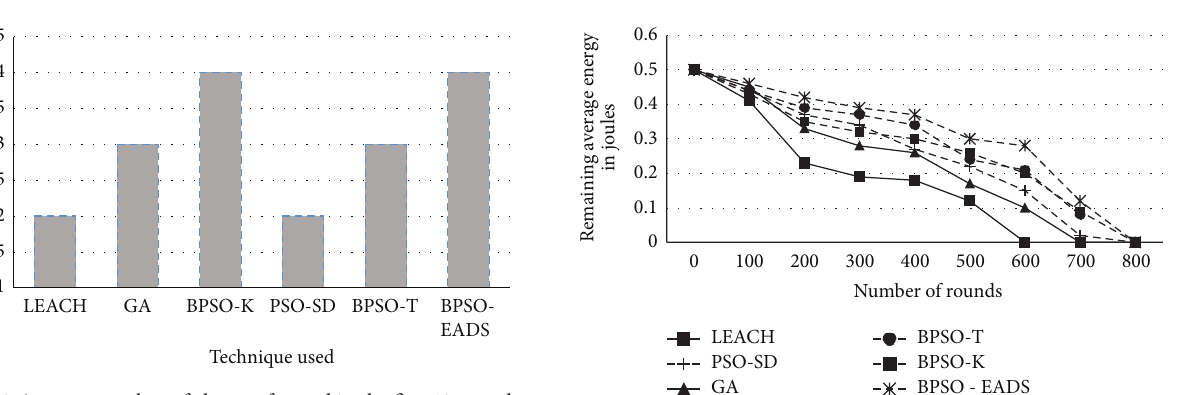
Figure 6: Average number of clusters formed in the first 10 rounds.